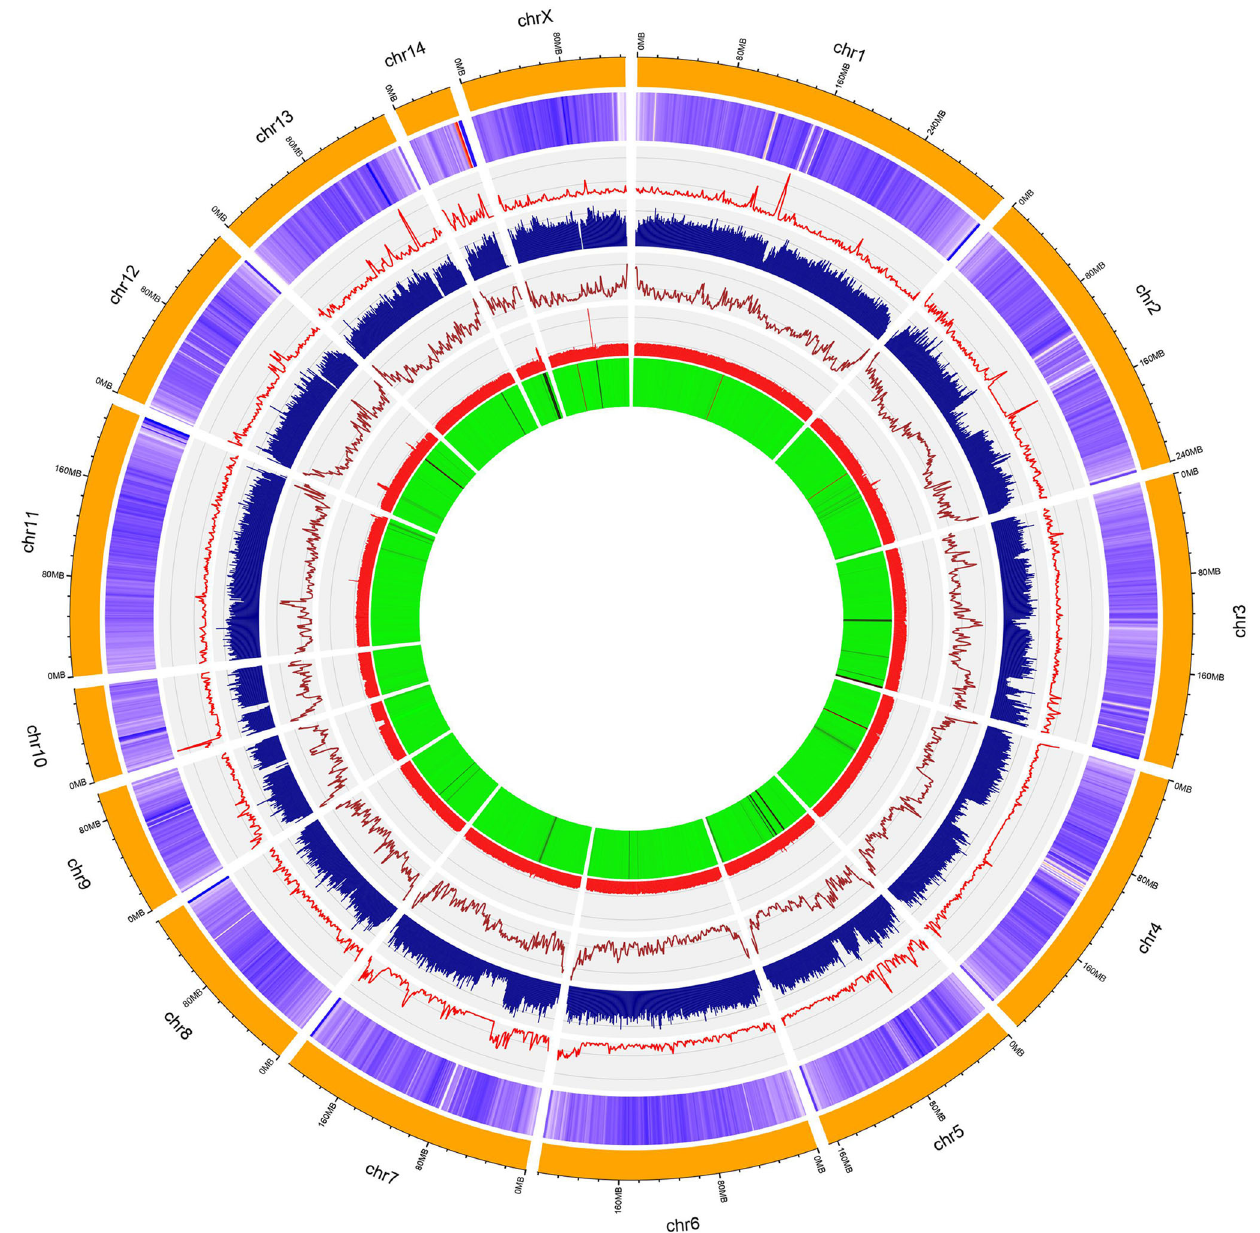
Fig. 2 Circos plot representing the 15 chromosomes of American mink genome (ASM_NN_V1). The layers present the heatmap of gene density (purple layer), line plot of SNP density (red layer), histogram of repeat density (blue layer), line plot of GC contents (brown layer), histogram of mapping rate for BGI short reads (pink layer), and heatmap for mapping rate of PacBio reads (green layer). The chromosome lengths were in the Mb unit and the genomic features were plotted for 1 Mb